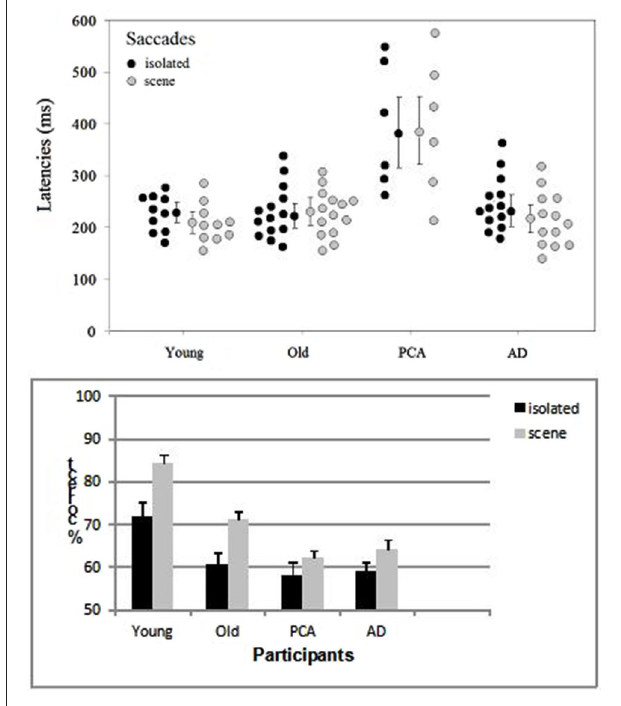
FIGURE 2 | Distribution of the mean saccade latency (with each group’s median and standard error) and accuracy (with the standard error) as a function of group (young adult controls, elderly adult controls, patients with AD and patients with PCA) and the type of image (isolated targets vs. targets in scenes)